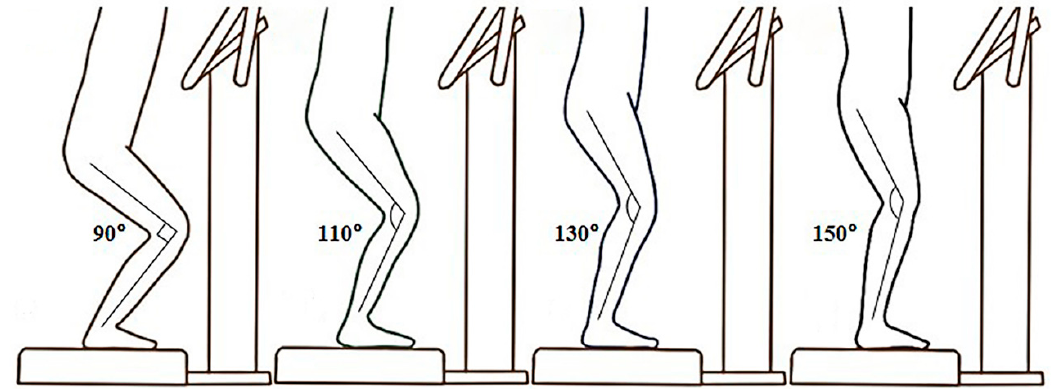
Figure 1. Postures of various knee angles under whole-body vibration